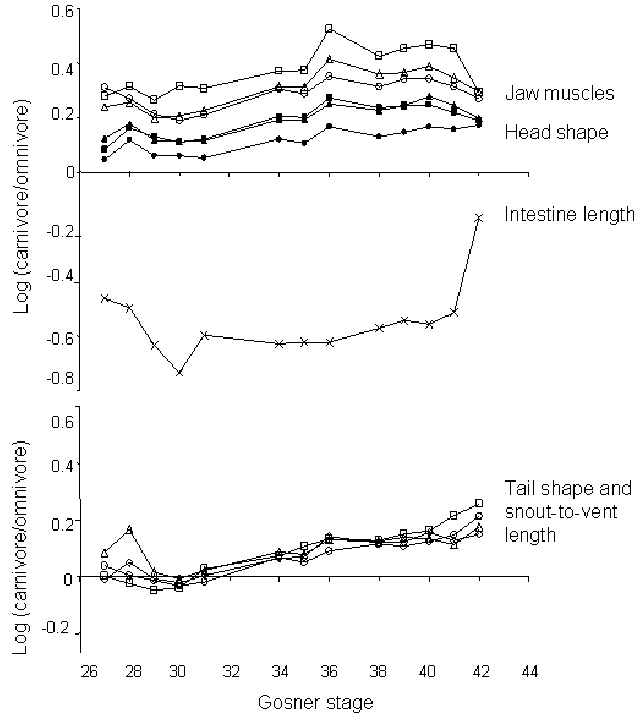
FIGURE 2 . Log (carnivore trait/omnivore trait) as a function of Gosner developmental stage. Means are represented. Jaw musculature (upper panel: hyoangularis, open squares; orbitohyoideus, open triangles; interhyoideus, open circles), head shape (upper panel: head length, filled triangle; head width, filled square; mouth width, filled circle), and intestines (upper panel: x symbol) show divergence at the earliest developmental stages, whereas tail shape (lower panel: tail length, open triangles; tail-muscle height, open circles; tail-fin height, open squares) and SVL (lower panel: open diamonds) show divergence at mid-larval